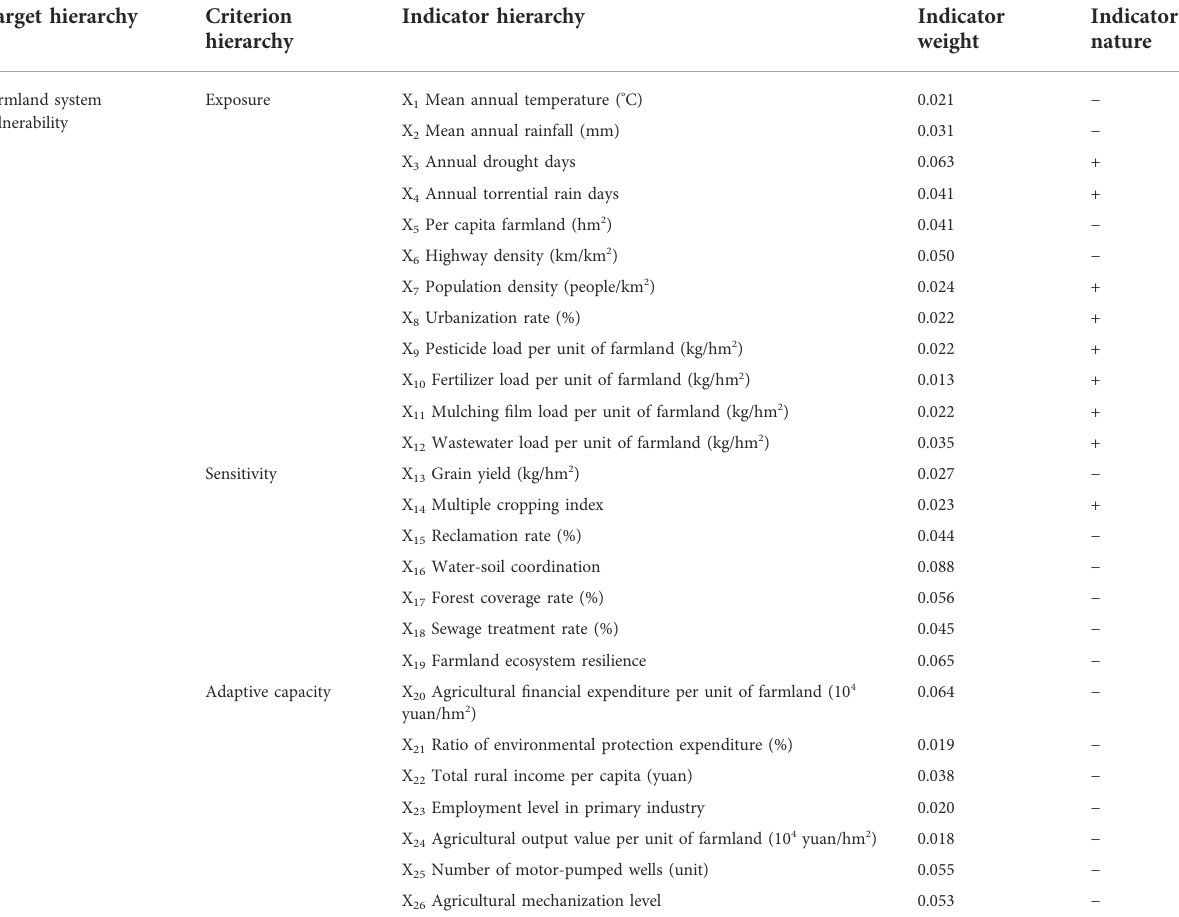
TABLE 2 Assessment indicator system for farmland system